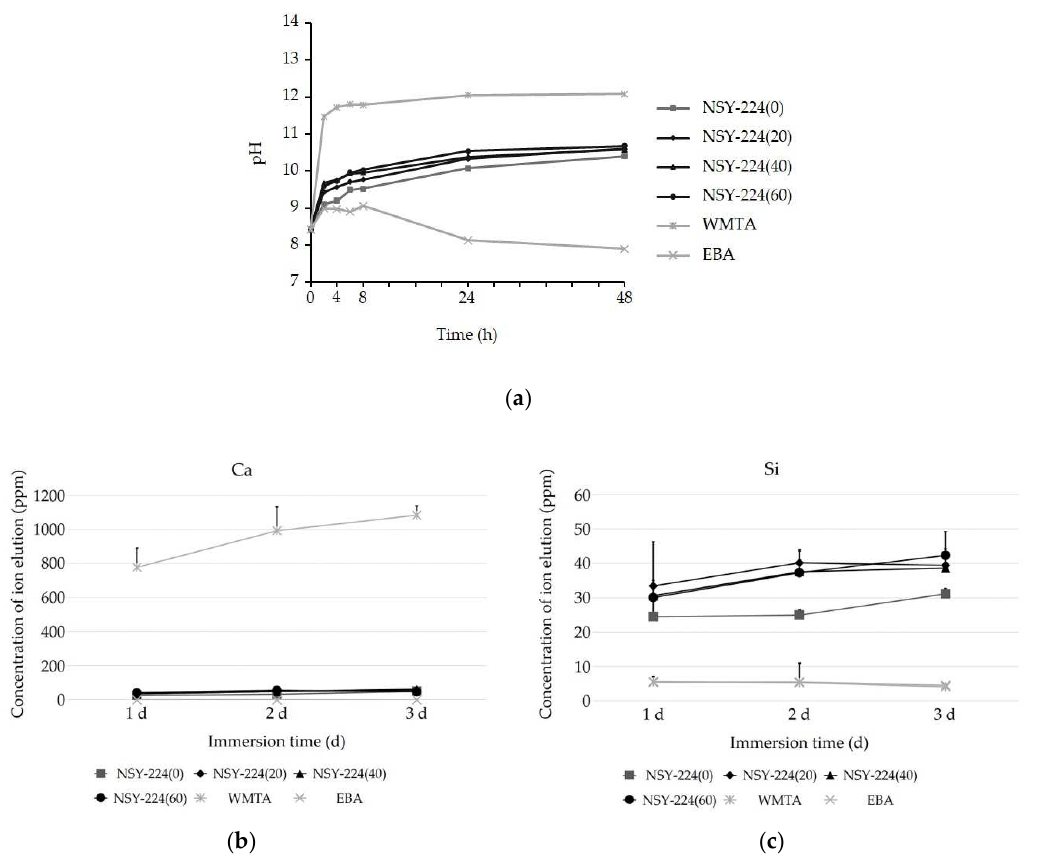
Figure 2. pH changes and ion elution of each cement specimen. ( a ) pH changes of the cement specimens immersed purified water. ( b ) Calcium ion and ( c ) silicon ion eluted from each cement. The data are expressed as means ± SDs ( n = 3).